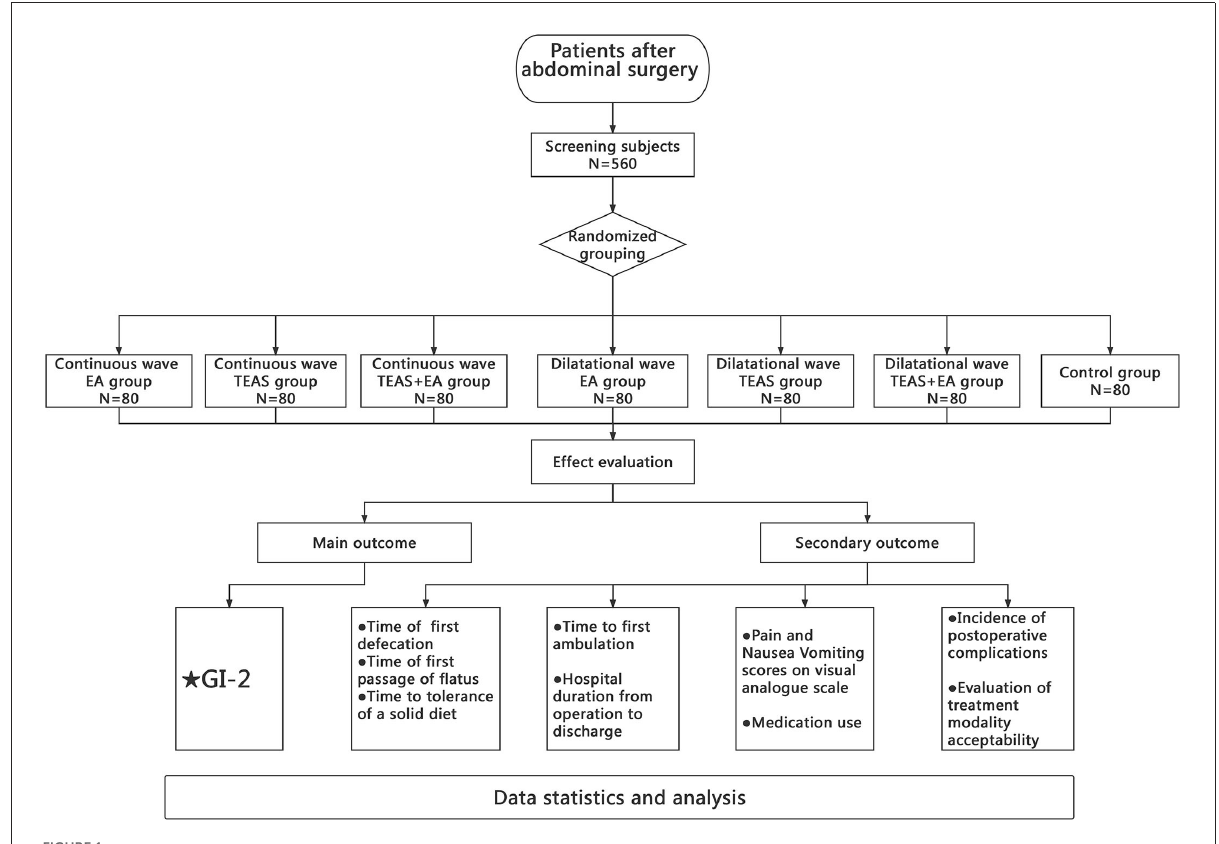
FIGURE1 Flowchart of the study